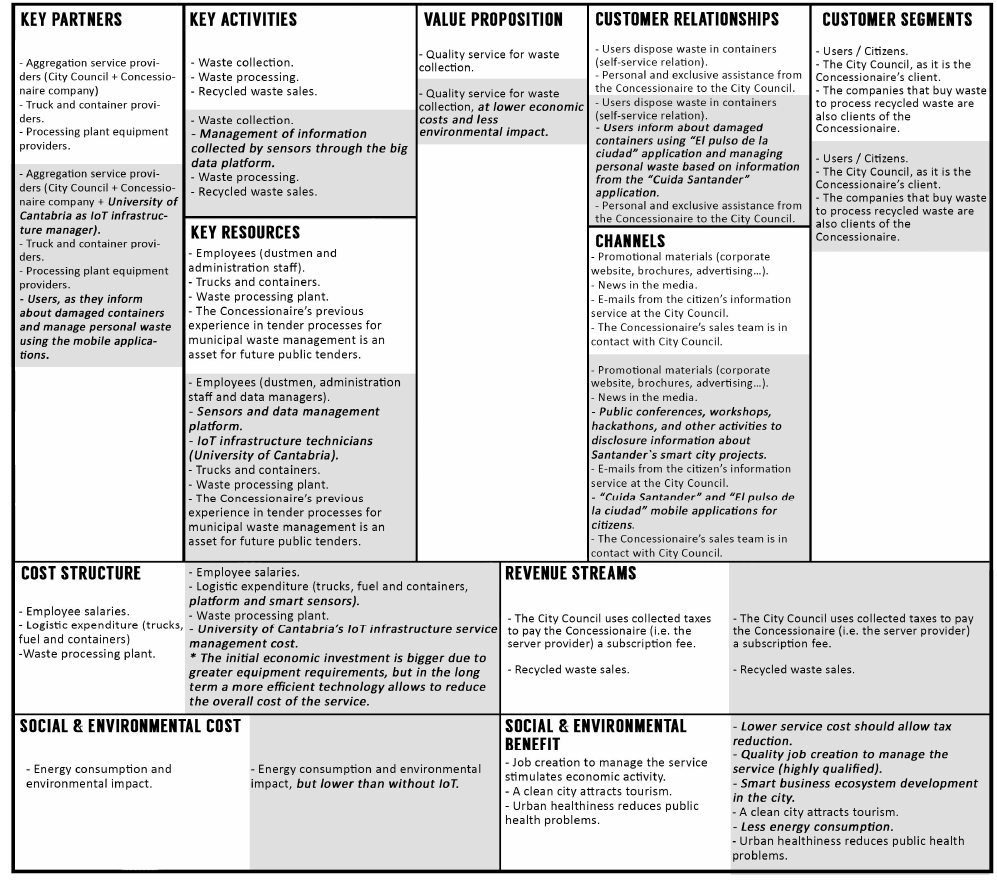
Table 3. Comparison of the business models of the conventional waste management service and the one integrating IoT infrastructure.